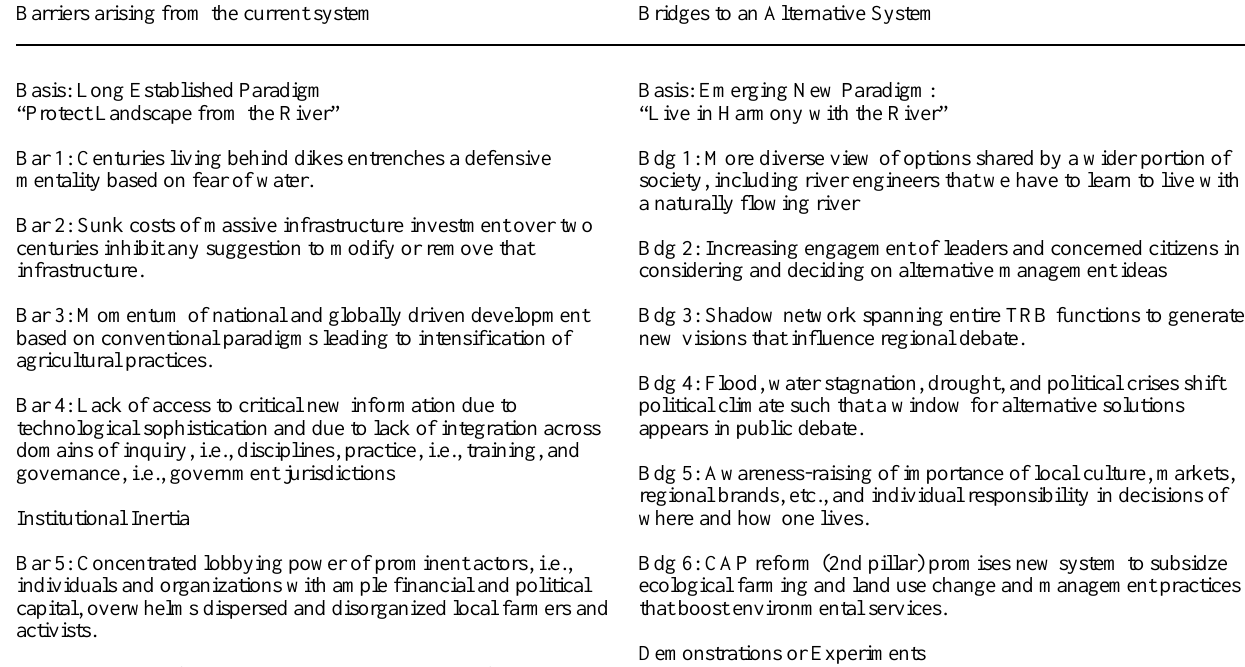
Table 1. Summary of major barriers and bridges to transformation of the Hungarian reaches of the Tisza River Basin (HTRB); not in order of importance or